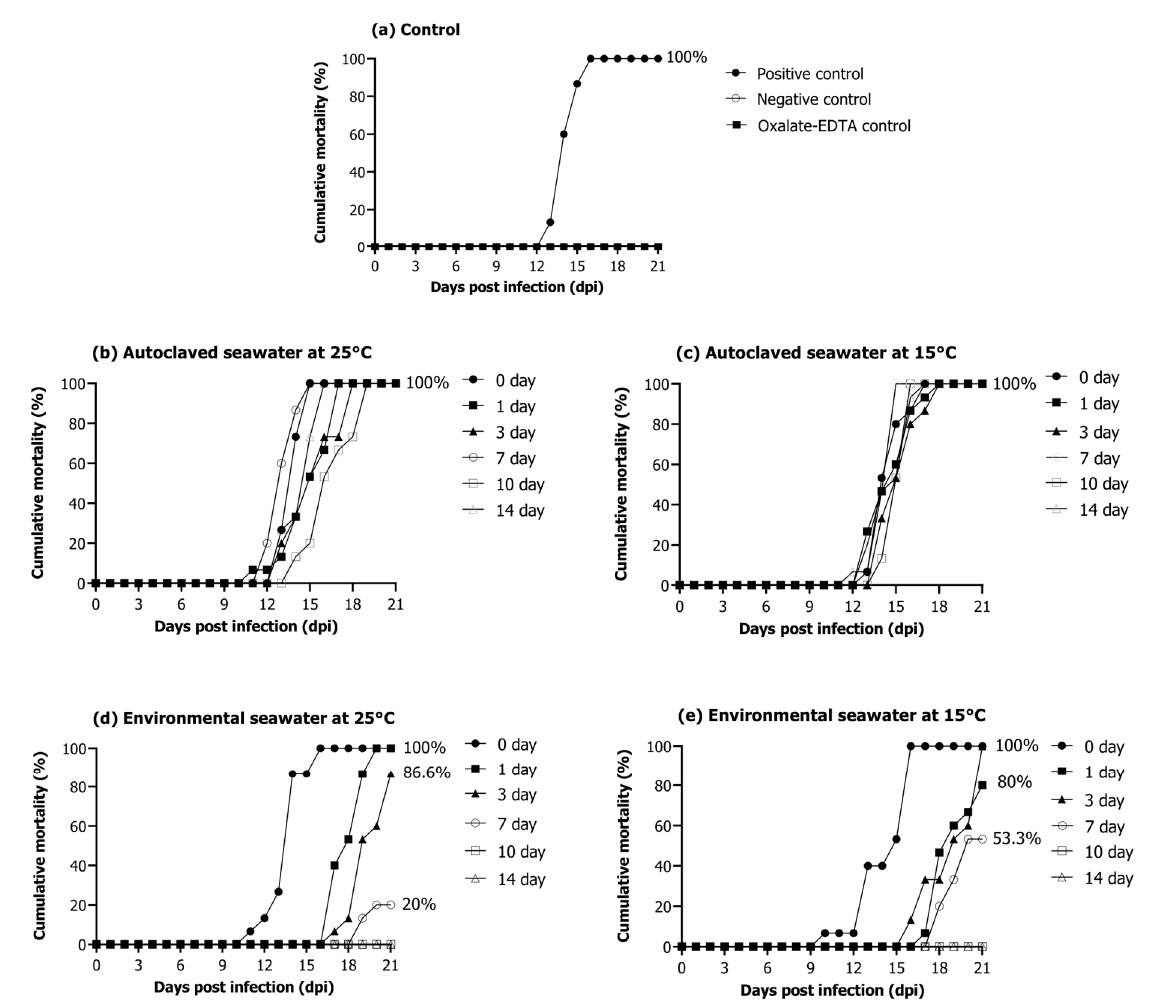
Figure 5. Cumulative mortality of rock bream after intraperitoneal injection of the resuspended virus after storing RSIV for different days in various seawater environments. ( a ) Positive control, 10 6.2 RSIV copies/fish (cell culture); negative control, PBS; oxalate-EDTA control and oxalate-EDTA buffer 10-fold dilution were injected. ( b , c ) Injection of RSIV stored in autoclaved seawater at 25 °C and 15 °C. ( d , e ) Injection of RSIV stored in environmental seawater at 25 °C and 15 °C.